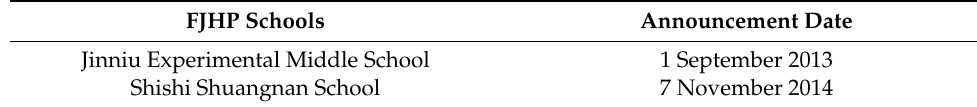
Table 2. Implementation time of the